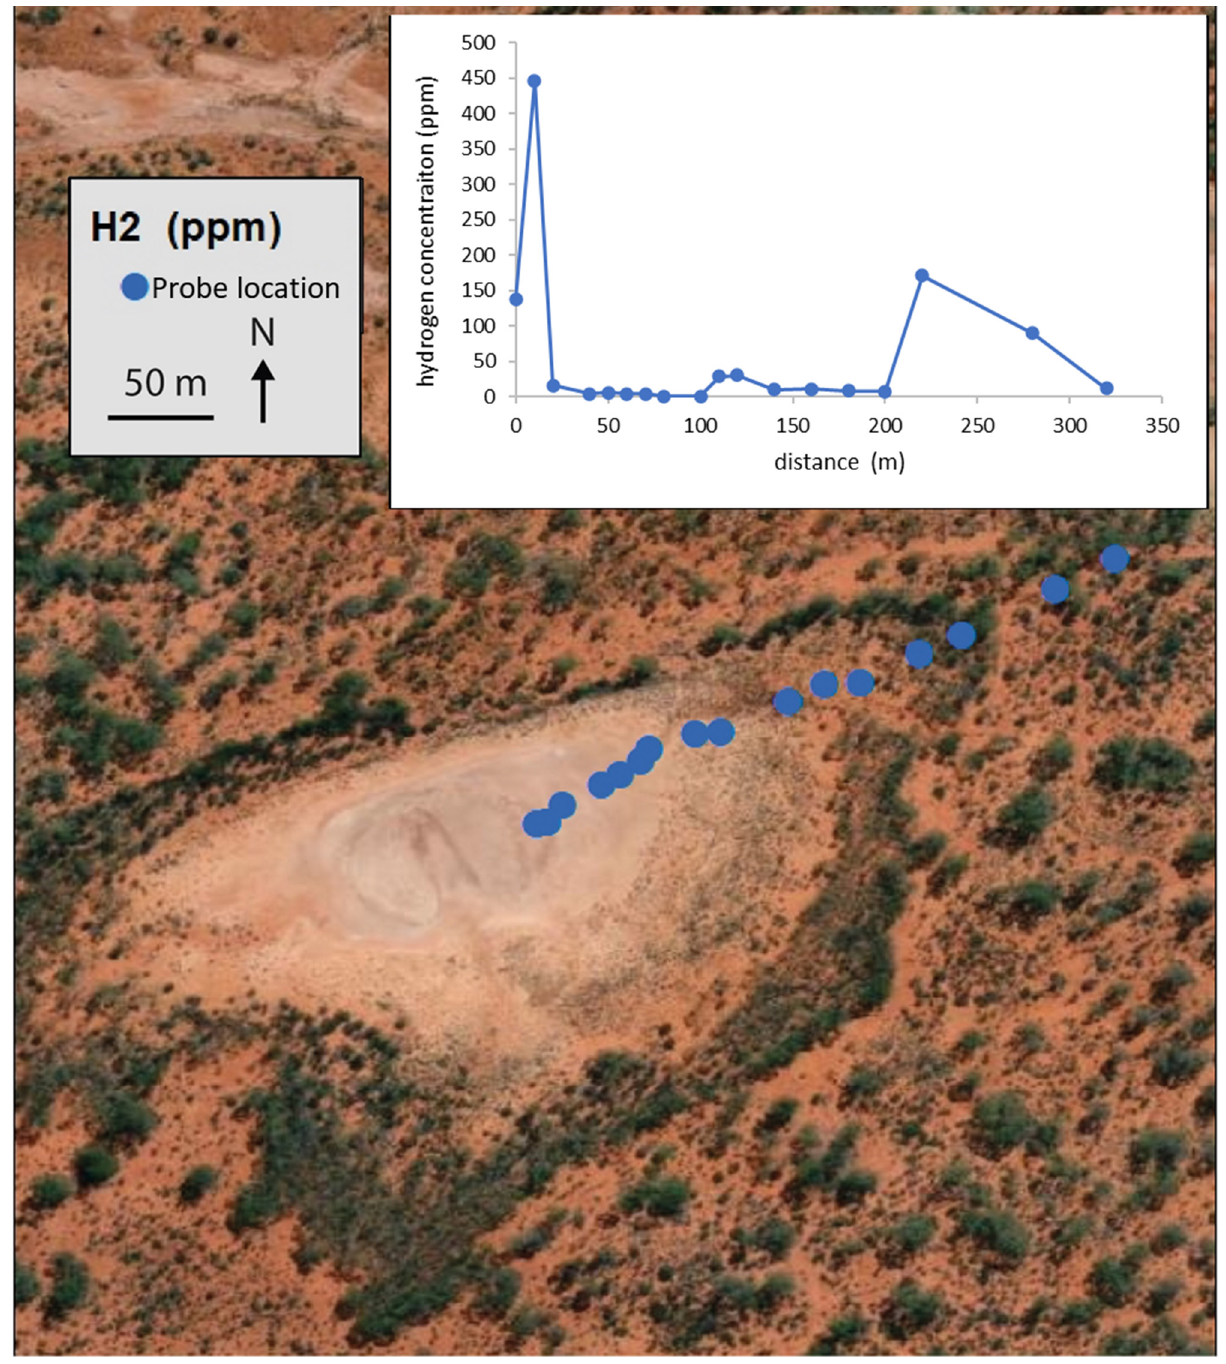
Figure 6. Soil-gas hydrogen measurement with GA5000 along a natural seep profile located north of Coolgardie, WA. Coolgardie,